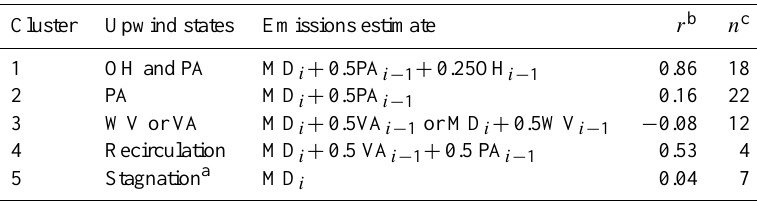
Table 1. Characteristics and emission estimates of each cluster. Correlation coefficients are for lower tropospheric column ozone over Maryland, regressed against emissions.